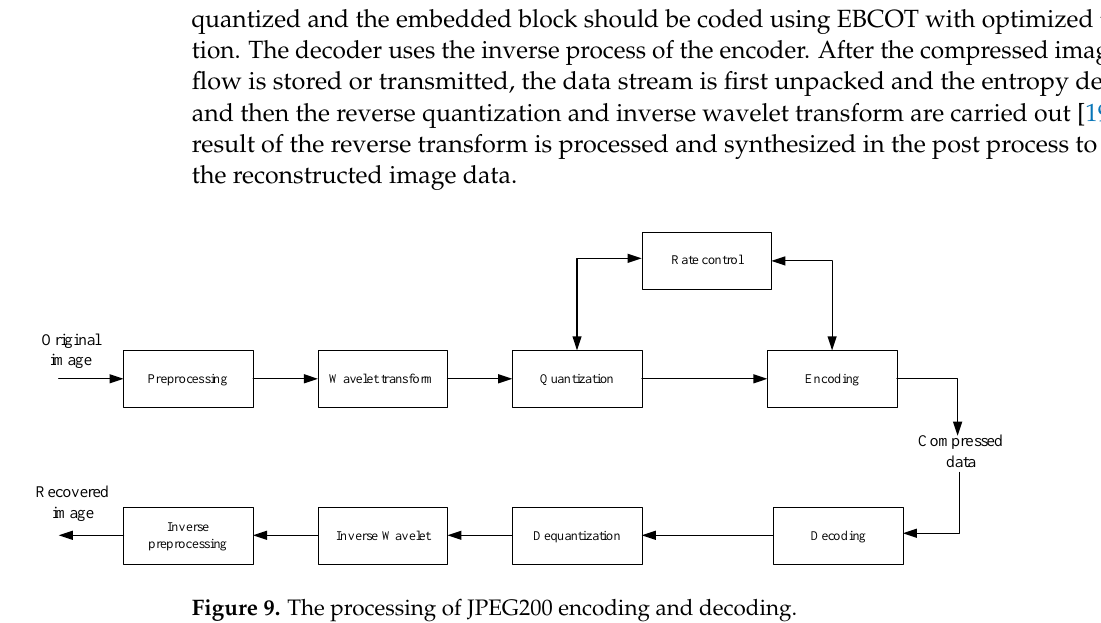
Figure 8. An example of the image segmentation detection method.